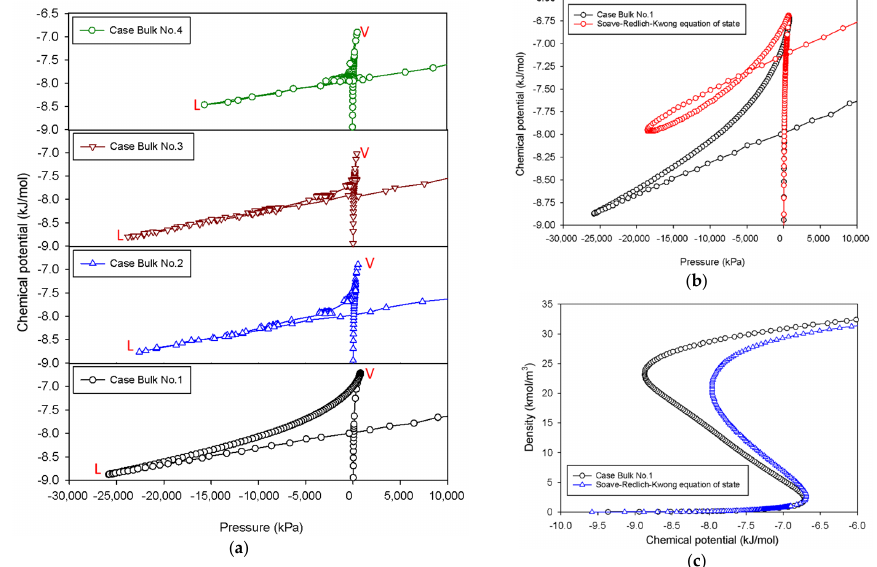
Figure 3. ( a ) Chemical potential vs pressure for the bulk phase transition of nitrogen at 77 K for four different scenarios. “V” and “L” stand for vapor and liquid spinodal points, respectively. ( b ) Chem- ical potential vs pressure for the bulk phase transition of nitrogen at 77 K for Bulk No.1 and that for Soave–Redlich–Kwong equation of state. ( c ) Bulk nitrogen isotherms of Bulk No.1 and Soave–Red- lich–Kwong equation of state.